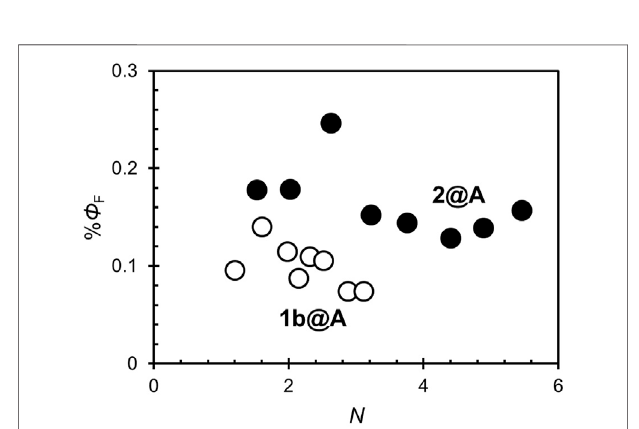
FIGURE 4 | Fluorescence quantum yields ( Φ F ) of 1b@A and 2@A with different N .